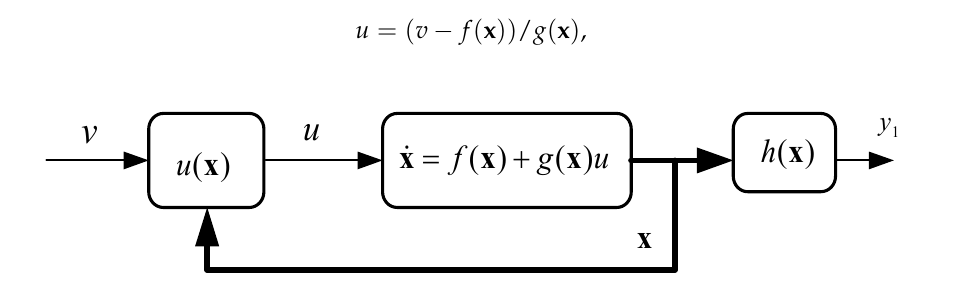
Figure 5. Block diagram of feedback linearization theory.